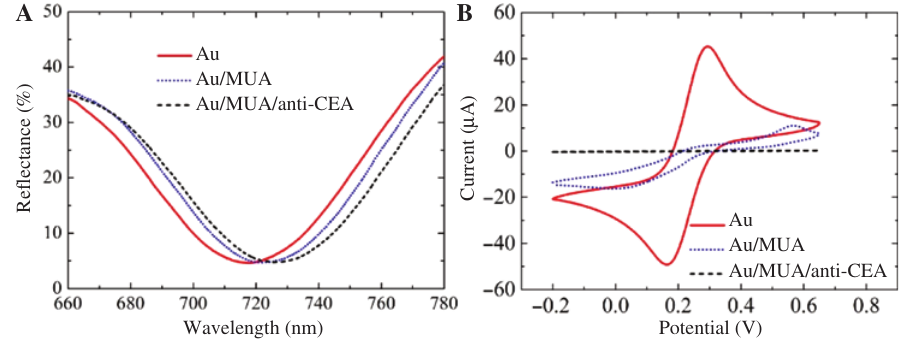
Figure 4: Characterizations of bare gold, gold with MUA, and gold with MUA/anti-CEA. (A) Reflectance spectra with filled deionized water in detection chambers. (B) Electrochemical voltammetry measurement of a gold electrode.